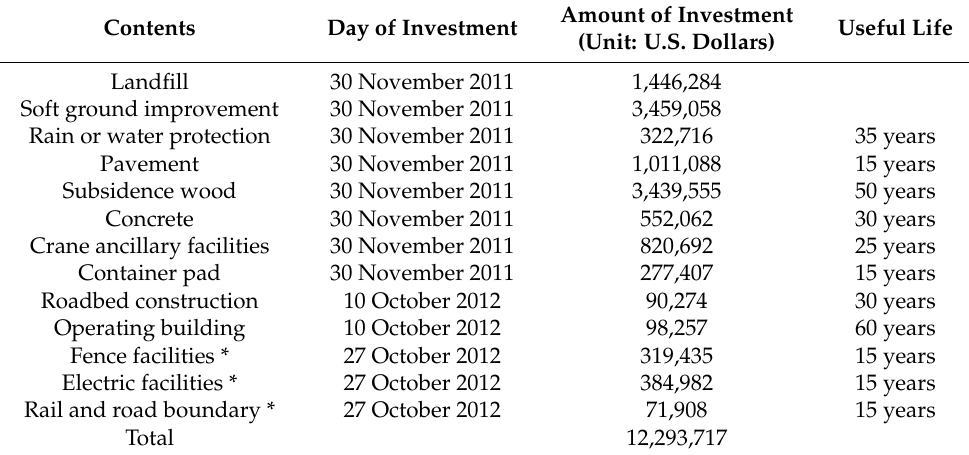
Table 2. Construction investment for the port railway